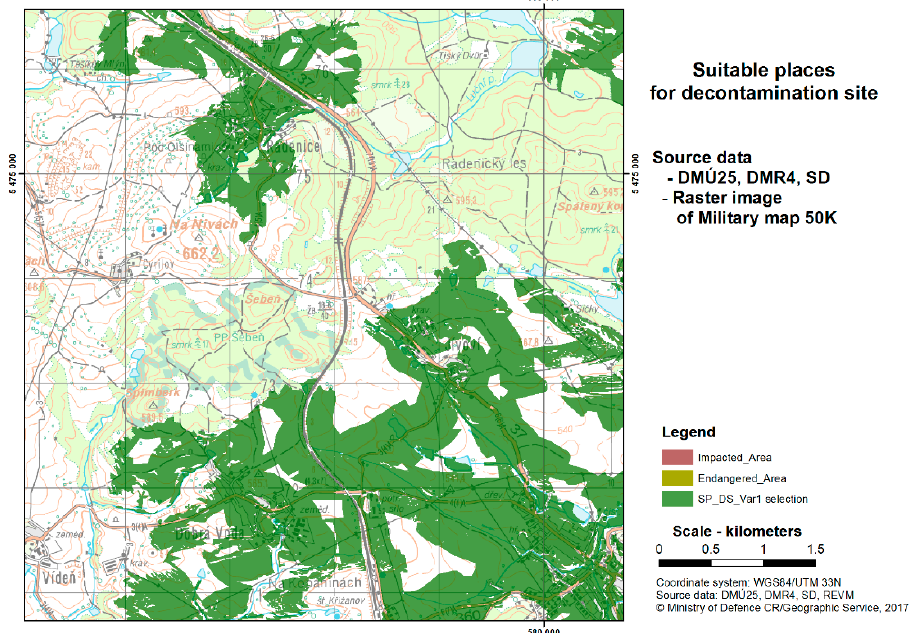
Figure 10. Suitable places for deployment of decontamination site; resulting analysis in detail; background map; and military topographic map, scale: 50,000.